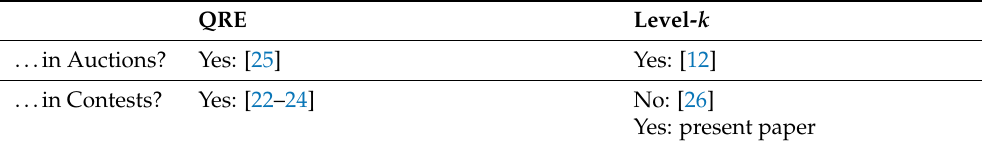
Table 1. Does bounded rationality rationalize overspending... QRE Level-